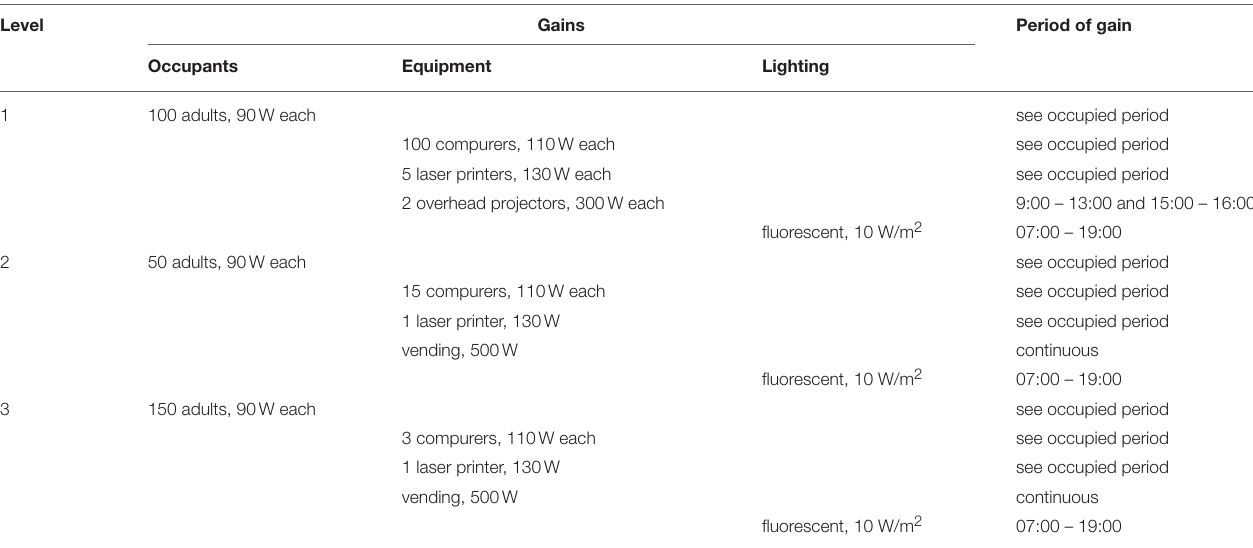
TABLE 1 | Building internal heat